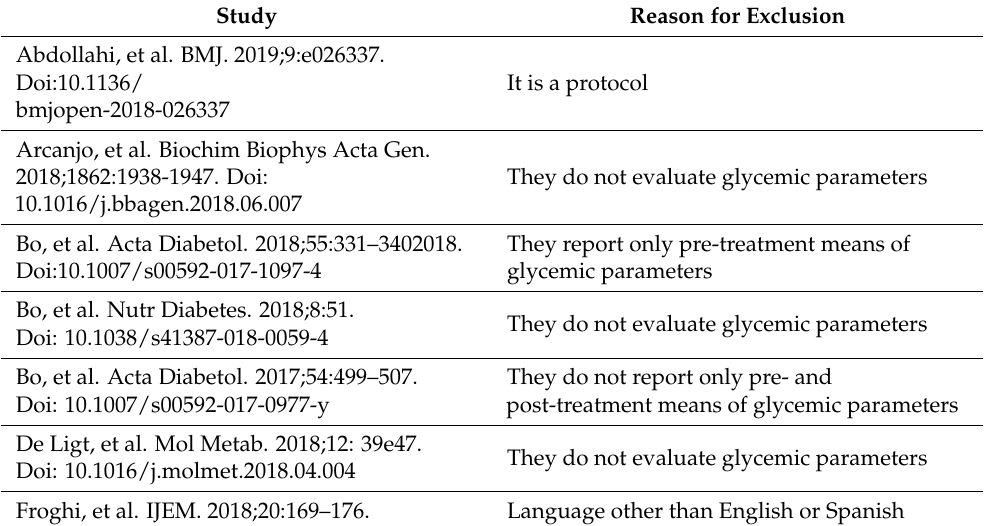
Table A1. Studies excluded from the systematic review.